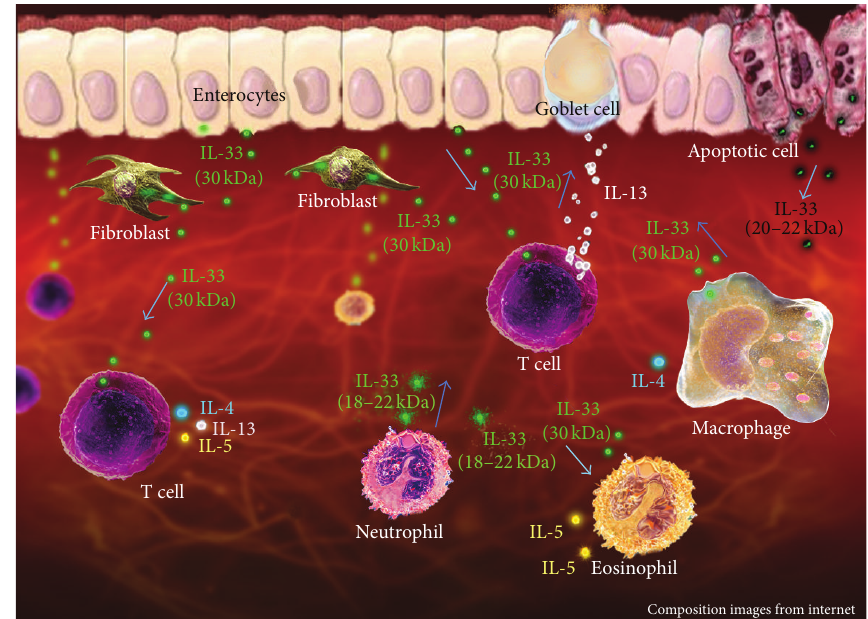
Figure 1: Representation of IL-33 function in the gastrointestinal mucosa. Full-length IL-33 (30kDa) is released by a wide range of different cell types, represented here by enterocytes, fibroblasts, and macrophages. IL-33 interacts with lamina propria T cells and determines the production of IL-4, IL-5, and IL-13. IL-13 enhances mucus production by goblet cells, while IL-5 activates eosinophils and B cells, and IL-4 induces Th2 polarization. IL-33 can also activate eosinophils and macrophages, further contributing to a Th2 response in the lamina propria. Neutrophil can release a lighter structure of IL-33 (18–22 kDa), which is known to be more active than the 30 kDa protein. During cellular apoptosis, IL-33 can be cleaved by caspases 3 and 7, generating a 20–22 kDa molecule, a potentially less active protein.